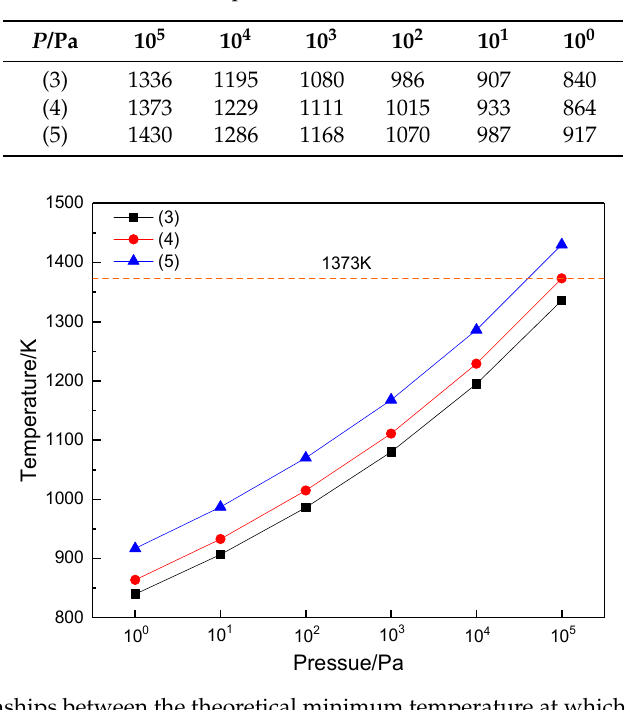
Figure 14. Relationships between the theoretical minimum temperature at which the reaction could occur and pressure.